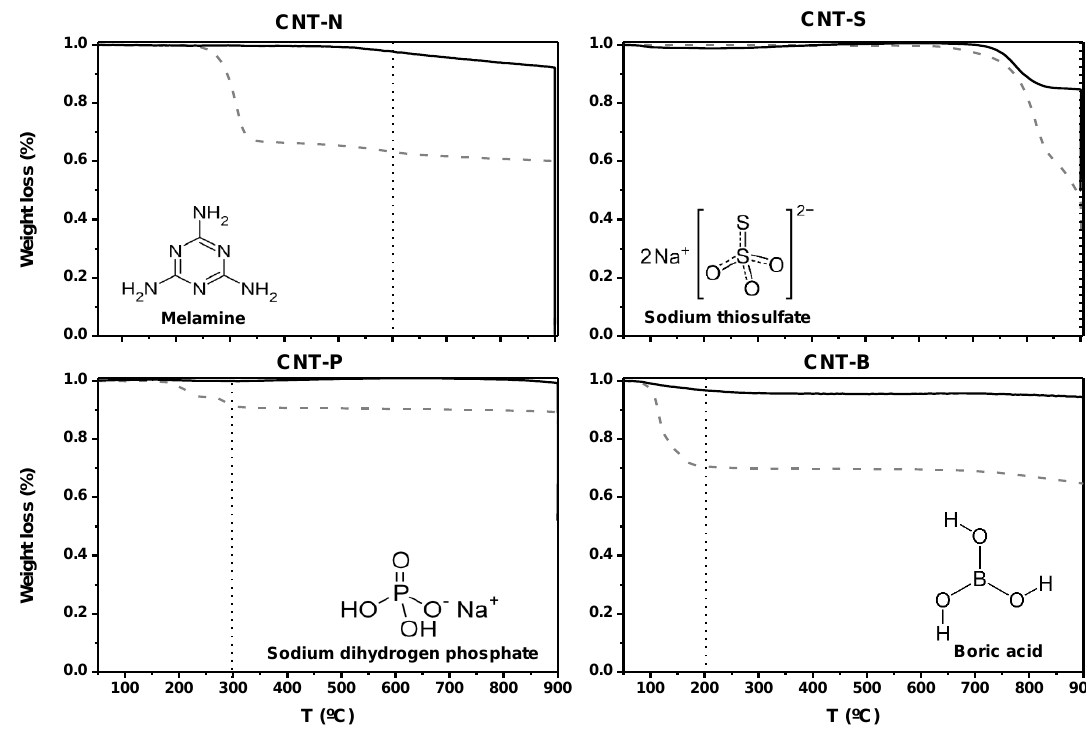
Figure 3. Thermogravimetric analysis (TGA) profiles under nitrogen of the modified carbon nanotube samples.